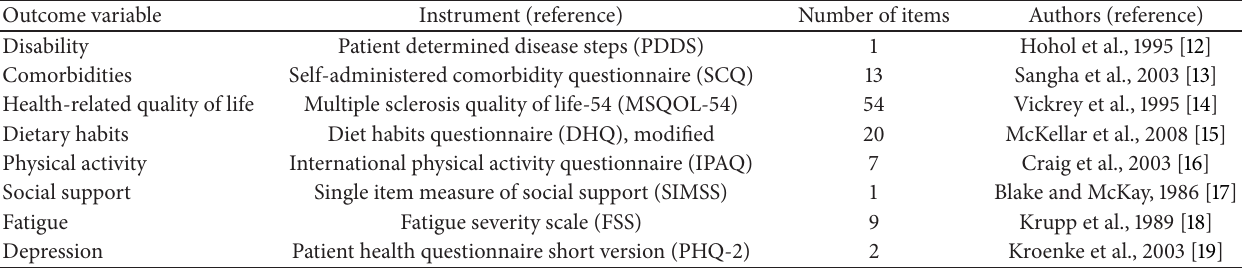
Table 1: Summary of validated tools